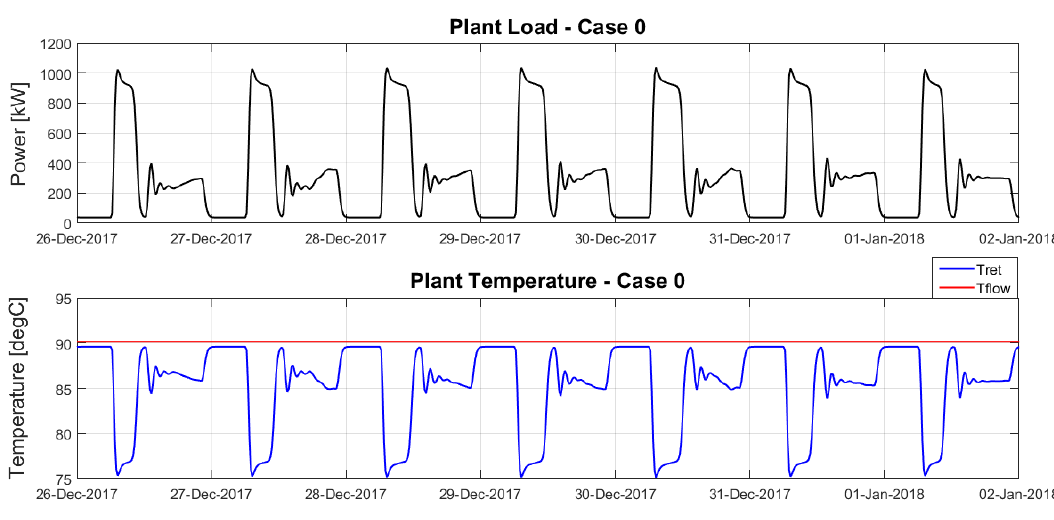
Figure 4. Baseline heat profiles of the heat supplied to the network.